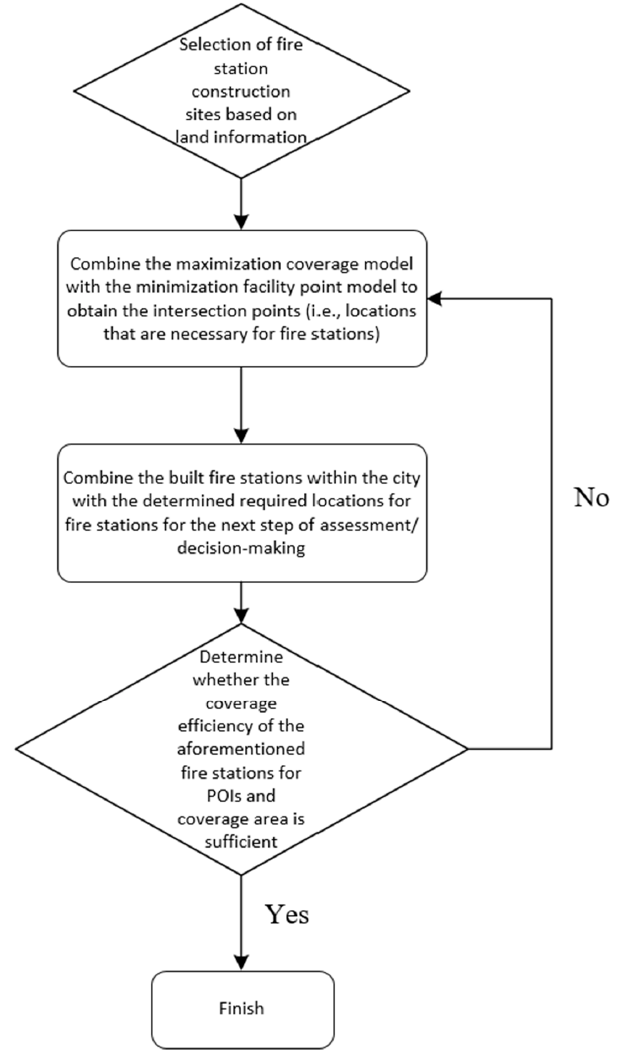
Figure 2. Flowchart of the proposed method.